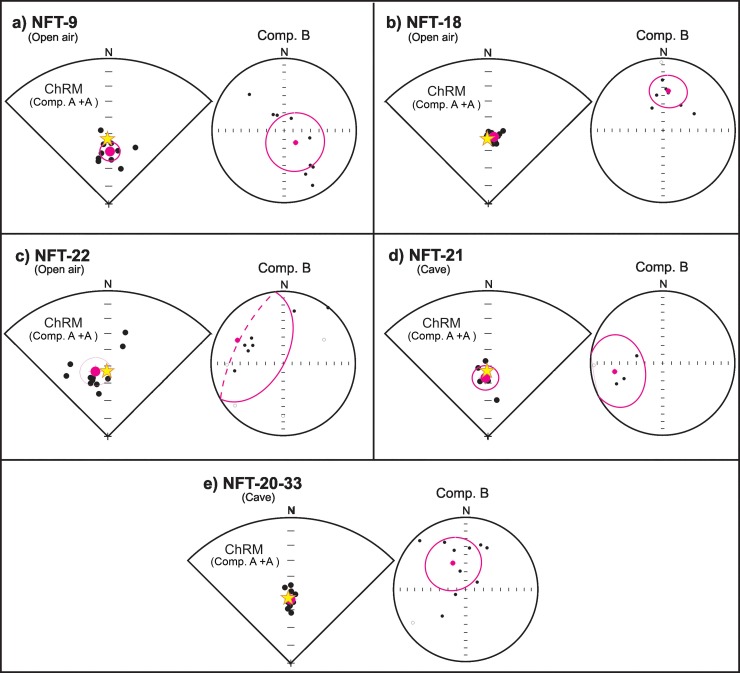
Equal area projections of the mean directions obtained.(A) NFT-9; (B) NFT-18; (C) NFT-20-33; (D) NFT-21; (E) NFT-22. Equal area projection shows the paleomagnetic directions described in the text of every specimen considered reliable (black points) and the mean direction obtained with its respective α95 semi angle of confidence (95% of probability), depicted as pink point and pink circle, respectively. The declination reads clockwise and is represented around the perimeter of the circumference, while the inclination varies from 0° (perimeter) to 90° (center of the circumference). Solid (open) symbols correspond to downward (upward) inclination. In the left part of each panel, ChRM mean direction (components A and A1) is shown; in the right part, the mean direction of the high-temperature component (component B). The yellow star is the expected Earth´s magnetic field direction at the time of burning.